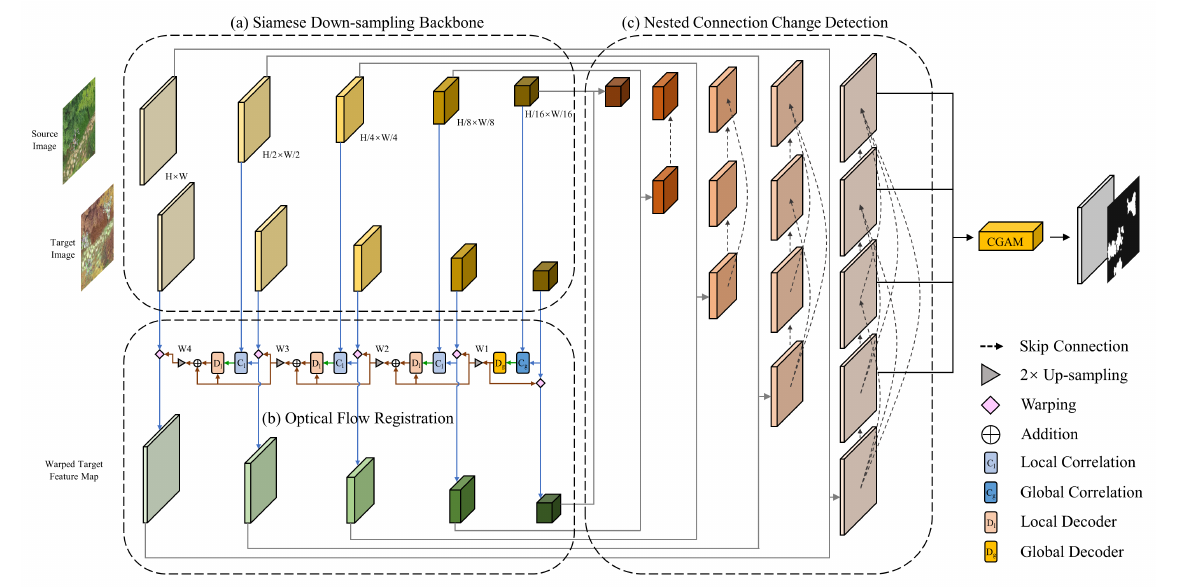
Figure 1. The architecture of the RegCD